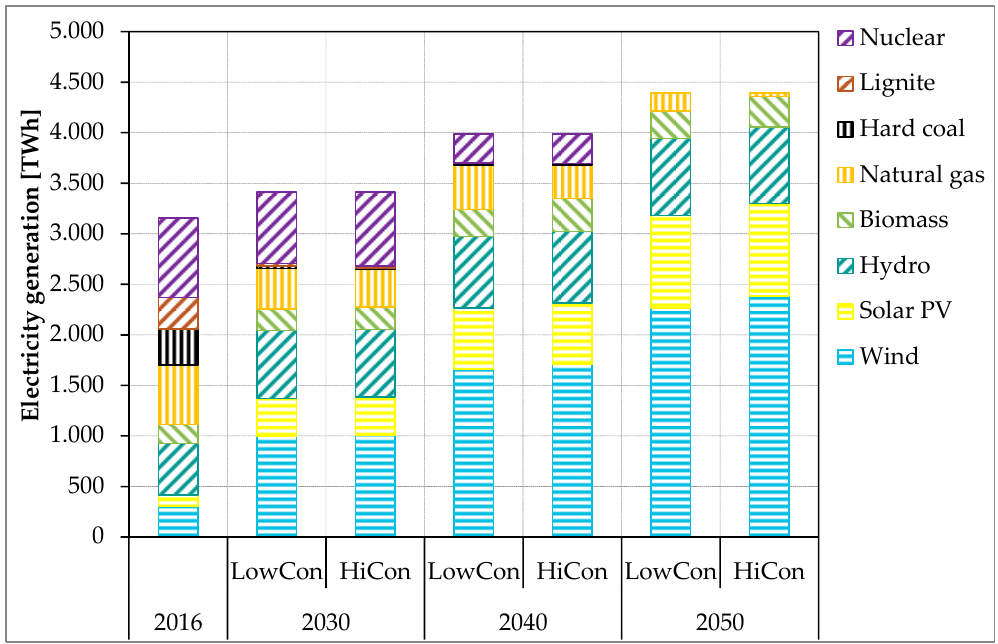
Figure 10. Electricity generation in the ENTSO-E area. Source: 2016 [32,35].